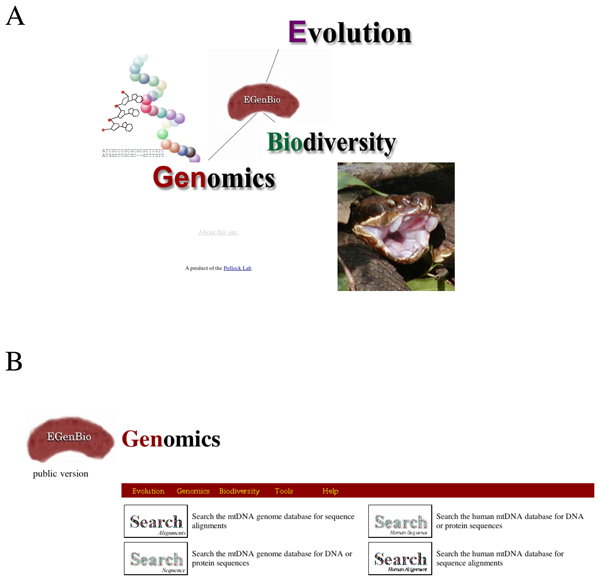
Organization of EGenBio. EGenBio is accessed through a splash page that links to the three main divisions, Evolution, Genomics, and Biodiversity (A). Each division has its own access page to the tools that are organized in that division. For example, the Genomics division page is shown in (B). The division of each page is clearly marked to allow quick movement among divisions and to the Tools section and mirrored Help pages.